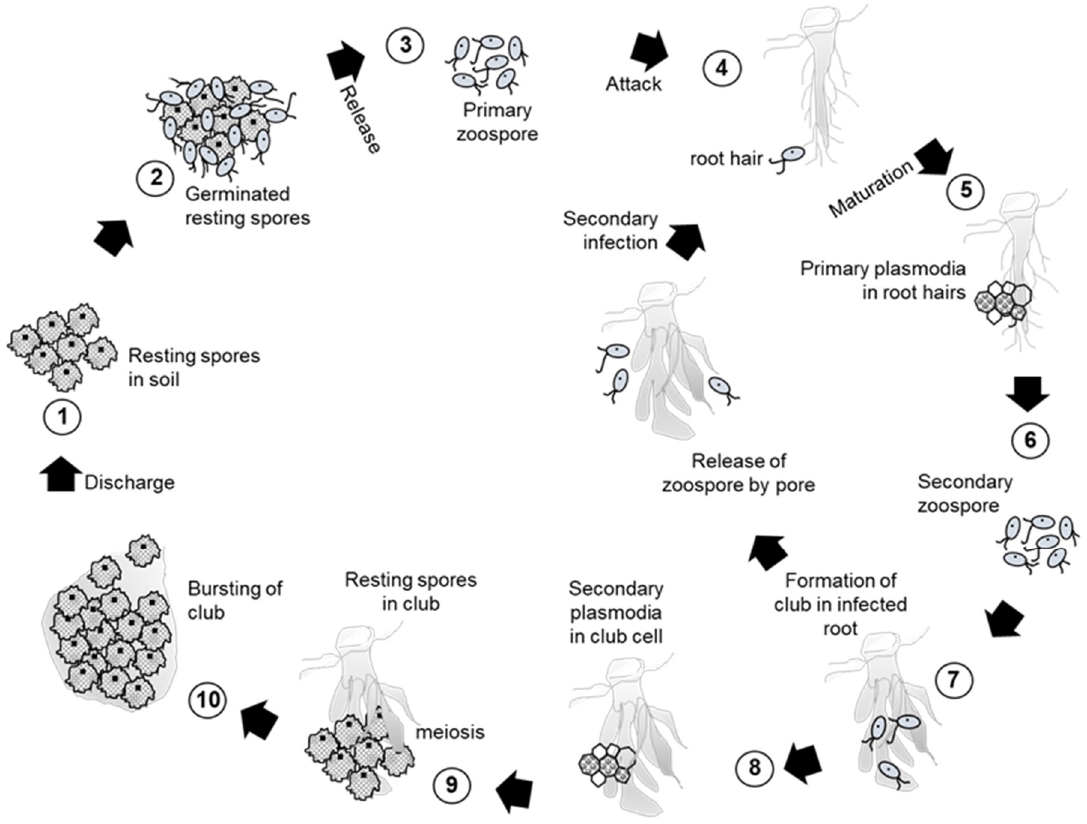
Figure 1. Infection process of clubroot disease caused by Plasmodiophora brassicae .